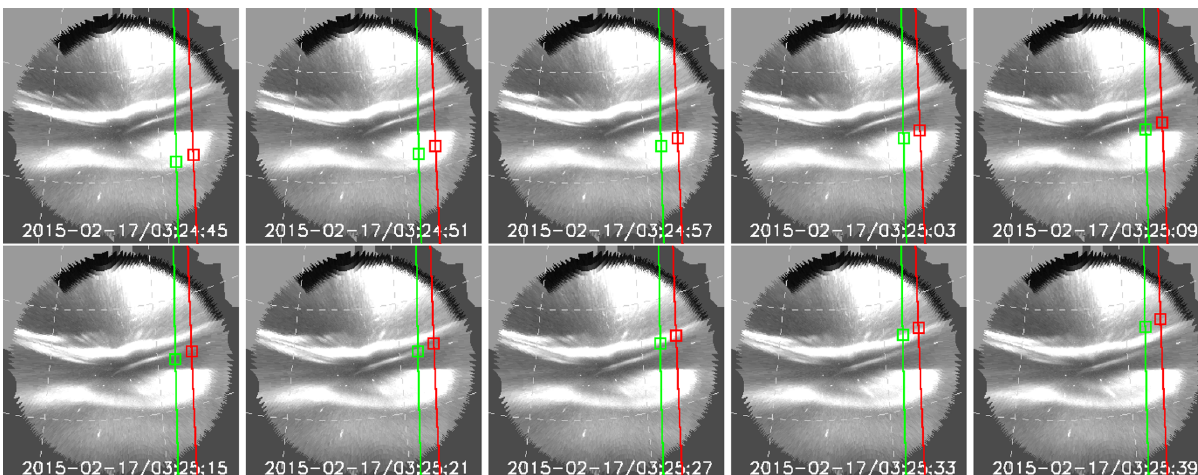
Figure 3. Optical frames from SNKQ station mapped in geographic coordinates. The tracks show the ionospheric projection of SwA (green) and SwC (red). At the time of the frame the spacecraft mapped position is shown by the square symbols. The time is overplotted on each frame and covers the interval from 03:24:45 to